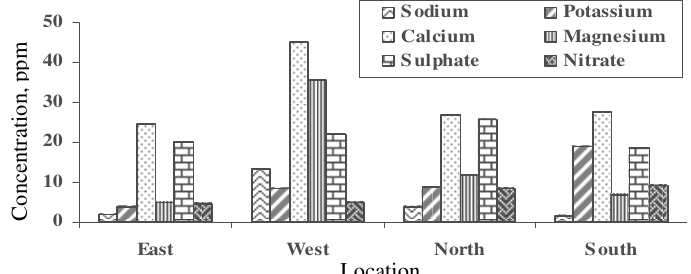
Figure 2 .Variation of Na + , K + , Ca 2+ , Mg 2+ , SO 42- and NO 3- ion in the groundwater samples.